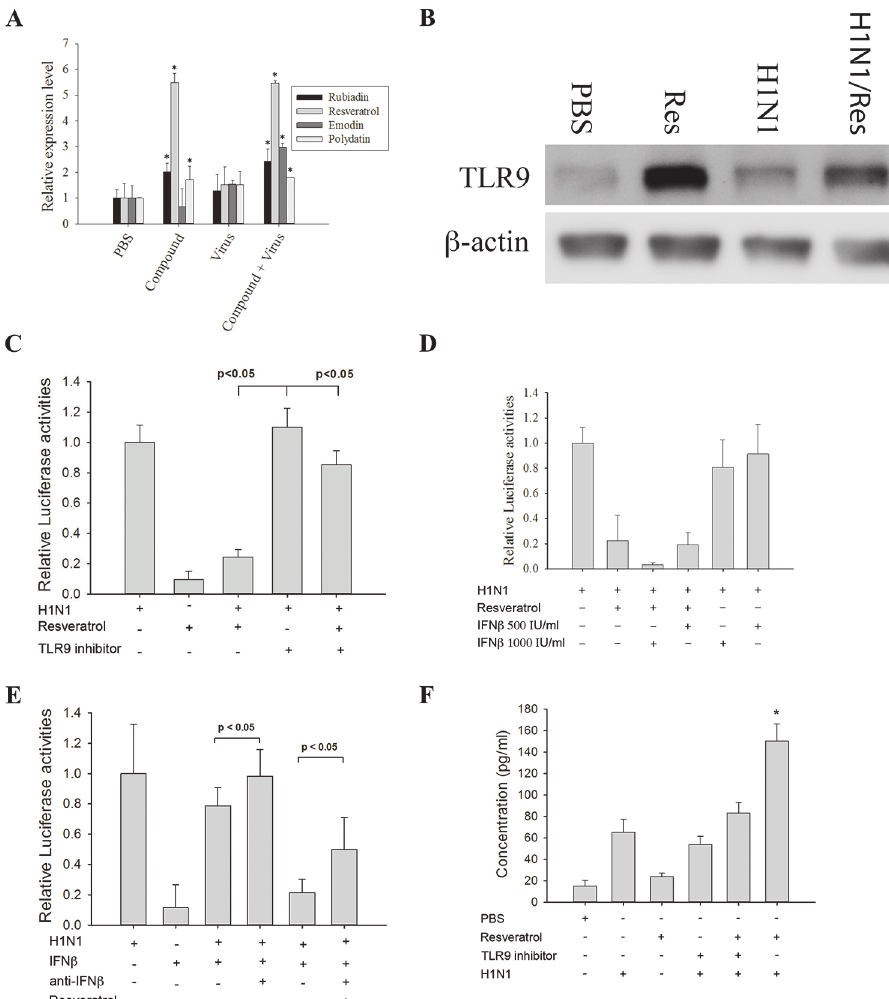
Fig 4. TLR9 and IFN- β acted synergistically with resveratrol to inhibit virus infection. (A) Resveratrol induces the expression of Toll-like receptor 9 (TLR9). A549 cells were treated as indicated and total RNAs were extracted to determine the TLR9 expression levels by real-time quantitative polymerase chain reaction (PCR). Results are the mean ± standard deviation of three independent experiments performed in triplicate. Asterisks indicate the calculated p values for paired comparisons between control (phosphate buffered saline; PBS) and drug treated samples are < 0.05. (B) Resveratrol increased the expression level of TLR9. A549 cells were treated with PBS (control), 25 μ M resveratrol, H1N1, H1N1 + 25 μ M resveratrol and the cell extracts were collected at 24 h post infection. The result shown is one of the Western blots from three independent experiments. (C) Inhibiting TLR9 reduced the anti-H1N1 effect of resveratrol. A549 cells were treated with/without TLR9 inhibitor for 3 h before infected with H1N1. After 24 h of infection, the amplified virus in the culture supernatant was applied to 293T cells stably transfected with the influenza A reporter to determine influenza A replication in the presence of a TLR9 inhibitor. (D) Resveratrol works synergistically with interferon- β (IFN- β ) to inhibit the replication of influenza A virus in lung cells. The treatments applied to A549 cells are listed in the figure. The amplified virus in the culture supernatant was applied to 293T cells stably transfected with influenza A reporter to determine influenza A replication in the presence of different treatments. The p values from Student ’ s t-tests for the paired comparisons of 25 μ M resveratrol; 25 μ M resveratrol + 1000 IU/mL IFN- β ; 25 μ M resveratrol + 500 IU/mL IFN- β versus the control are all < 0.05. A p value < 0.05 is considered as significant. (E) Neutralizing IFN- β antibodies reduced the anti-viral activity of resveratrol. A549 cells were infected with 10 MOI H1N1. The treatments of A549 cells were listed in the figure. After 24 h of infection, the amplified virus in the culture supernatant was applied to 293T cells stably transfected with the influenza A reporter to determine influenza A replication in the presence of neutralizing anti-IFN β antibodies. (F) A549 cells expressed IFN- β when treated with H1N1 or H1N1 + resveratrol. The treatments applied to the A549 cells are listed in the figure. After 24 h of infection, cell culture supernatants were collected to determine the IFN- β concentration (by ELISA). The p value from Student ’ s t-tests for the paired comparisons of H1N1 with H1N1 + resveratrol is < 0.05. A p value < 0.05 is considered as